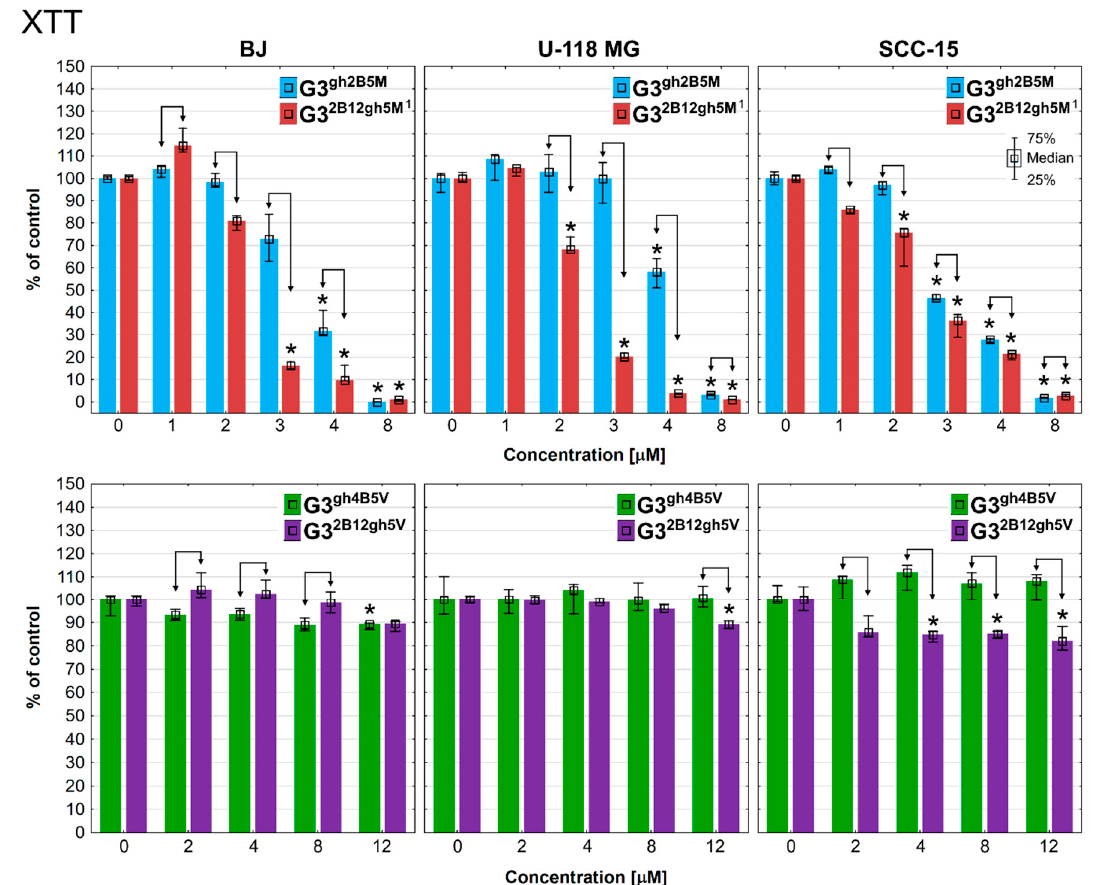
Figure 4. Viability of normal fibroblasts (BJ), glioblastoma cells (U-118 MG) and squamous carci- noma cells (SCC-15) after 48 h of incubation with G3 gh2B5M , G3 2B12gh5M , G3 gh4B5V and G3 2B12gh5V , assessed by XTT assay. Cells viability (expressed as percent of the non-treated control) medians are plotted. The whiskers are lower (25%) and upper (75%) quartile ranges. * p ≤ 0.05; Kruskal-Wallis test (against non-treated control), ↕ p ≤ 0.05; Mann-Whitney U test (ester- against amide-attached drug-conjugate). 1 Data for G3 2B12gh5M were reproduced from [29].